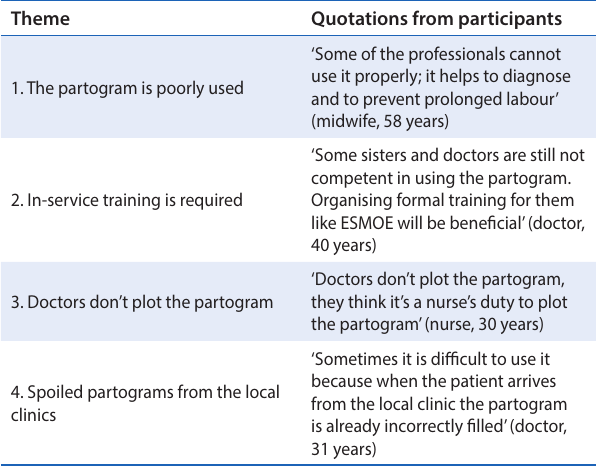
Table 6: Themes regarding